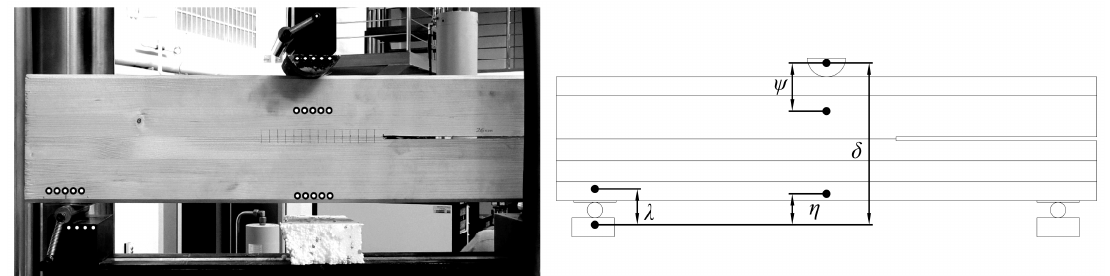
Figure 4. Digital image correlation (DIC) method and δ , λ , ψ , η parameters determination.